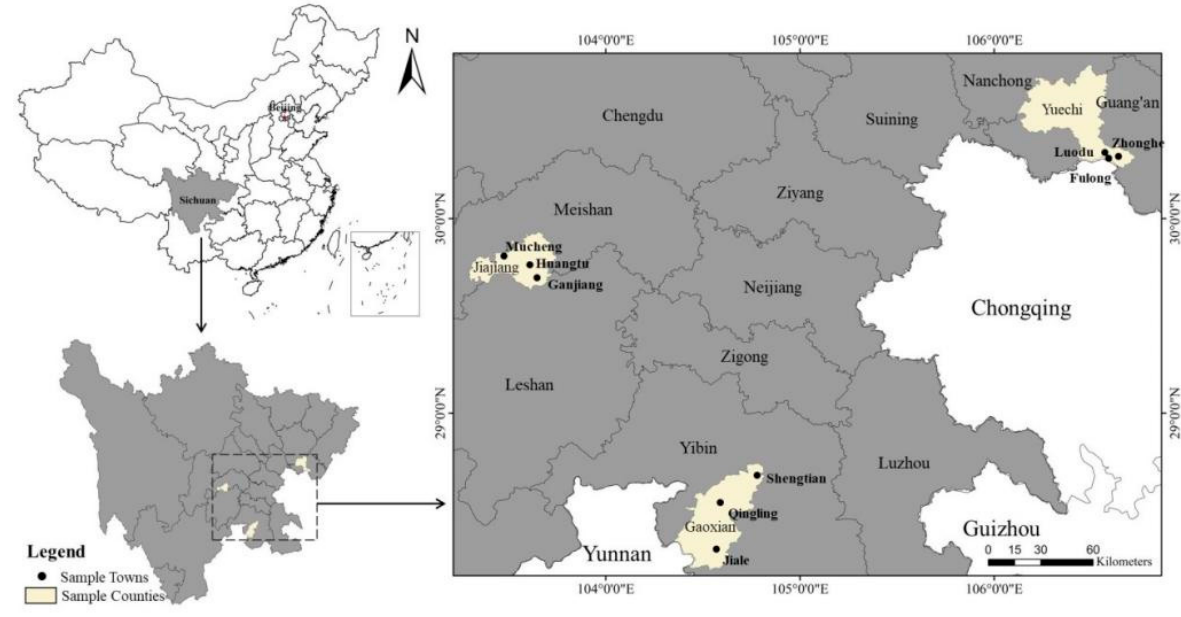
Figure 1. Location map of sample counties and